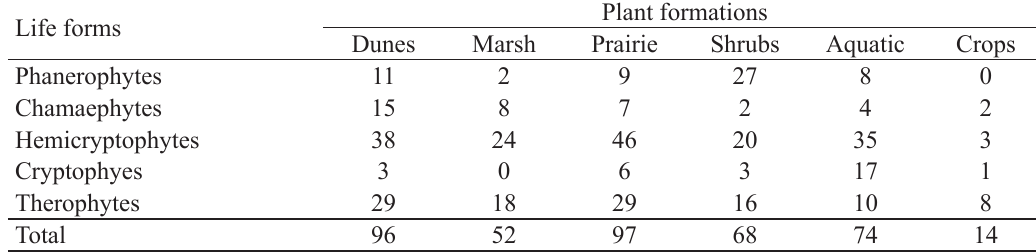
Table 4. Biological spectra according to the number of species by life form of study area plant formations. Life forms